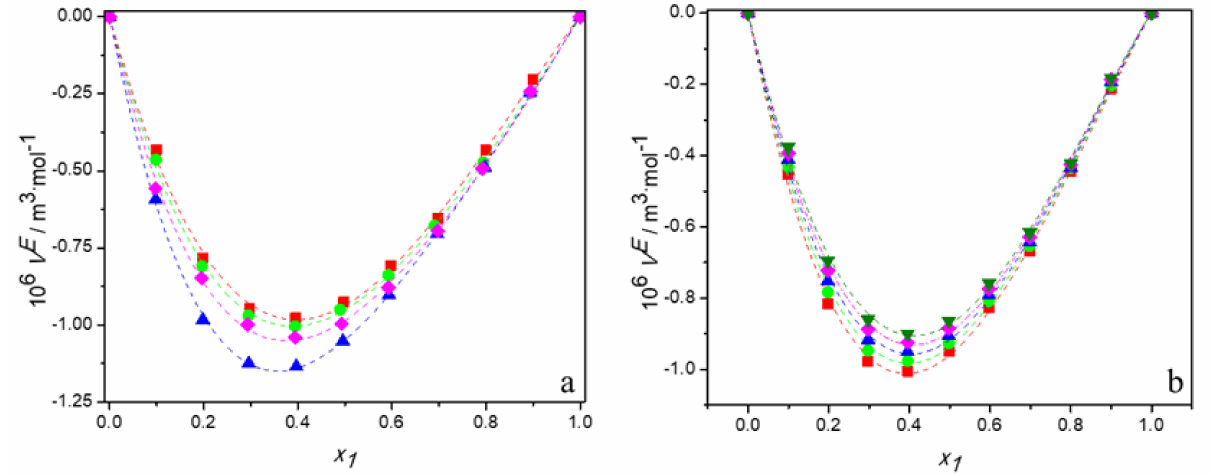
Figure 2. Dependence of the excess molar volume of aqueous solutions of DESs on molar fraction of deep eutectic solvent: ( a ) at 298.15 K for (cid:4) DES1; • DES2; (cid:78) DES3; (cid:7) DES4; ( b ) for DES1 at 298.15 K ( (cid:4) ); 298.15 K ( • ); 303.15 K ( (cid:78) ); 308.15 K ( (cid:7) ); 313.15 K ( (cid:72) ); —, Equation